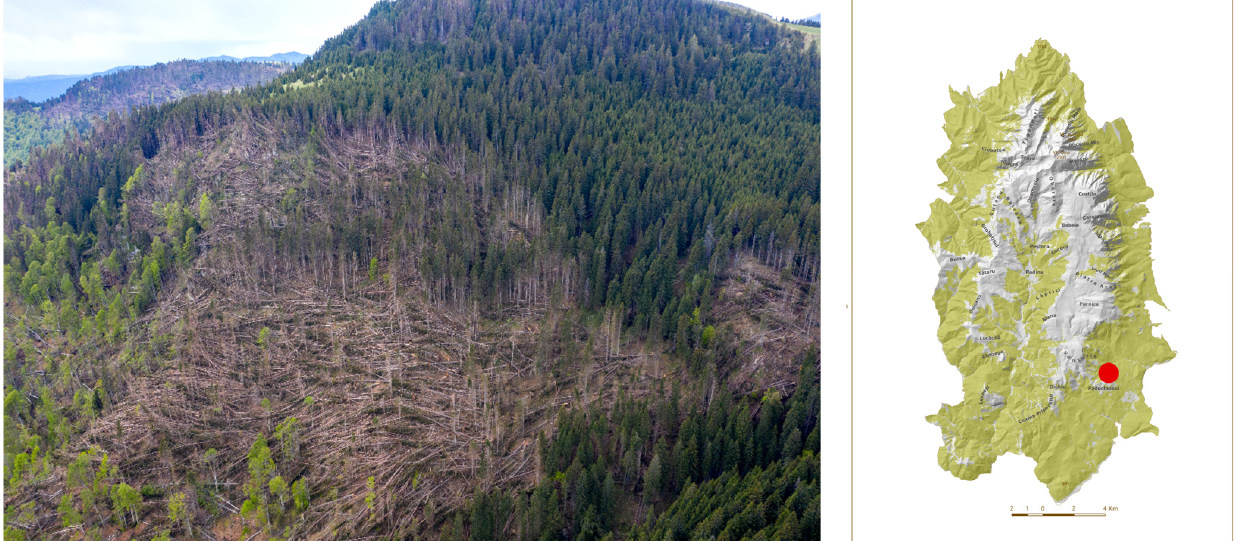
Figure 7. Drone aerial image of forest windthrow—P ă duchiosul Mountain, Sustainable Management Zone (Photo: Traian Dr ă ghici, May 2020) The situation map indicates the area the drone image was obtained.